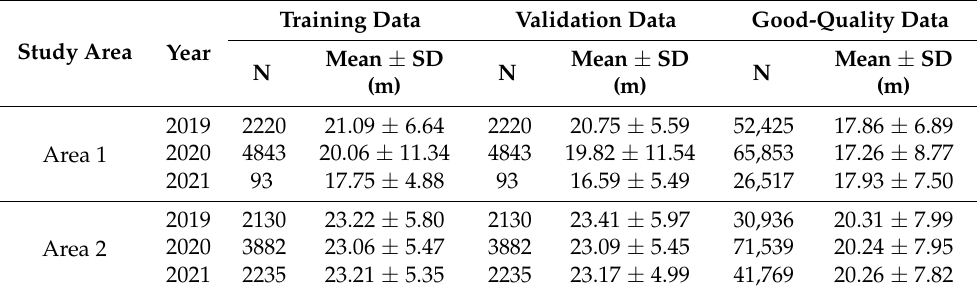
Table 2. The descriptive statistics of training, validation, and good-quality GEDI waveforms. The N is the number of observations with a mean and standard deviation (SD) of canopy